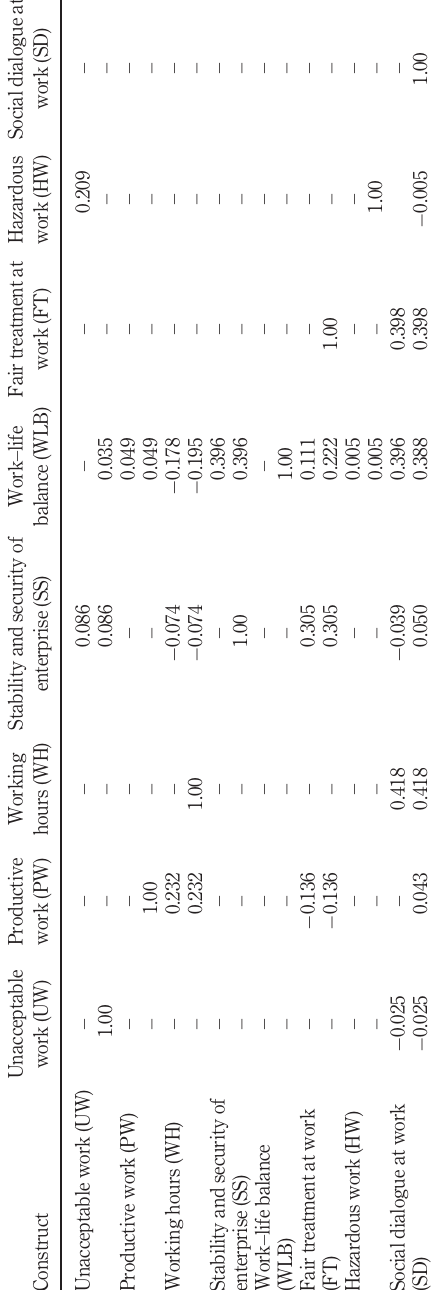
Table V. Path coefficients